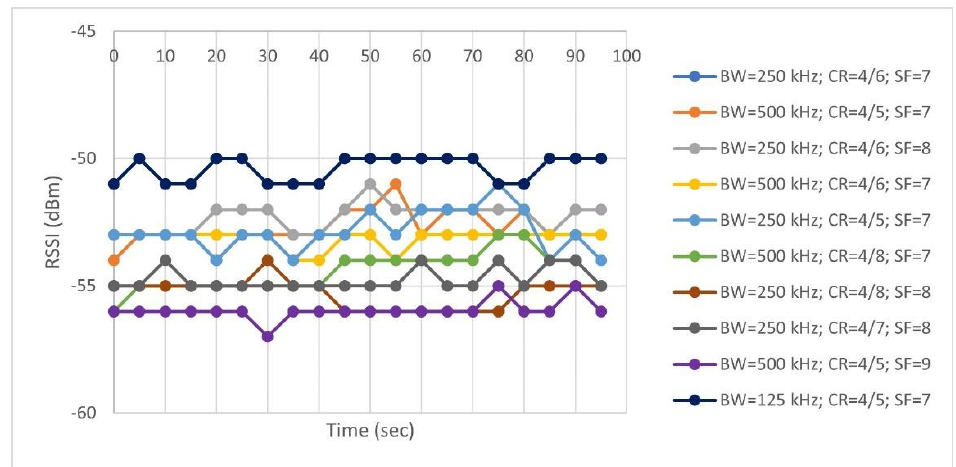
Figure 7. Receive signal strength indicator (RSSI) values for the best 10 settings in Experiment 1.